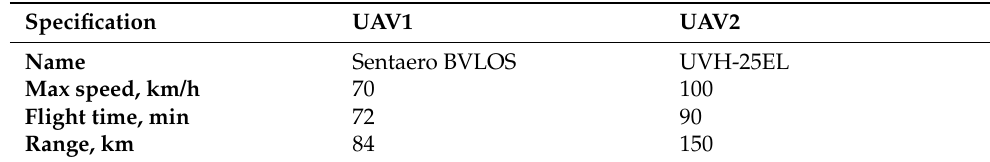
Table 2. Specification of the UAV models represented in the